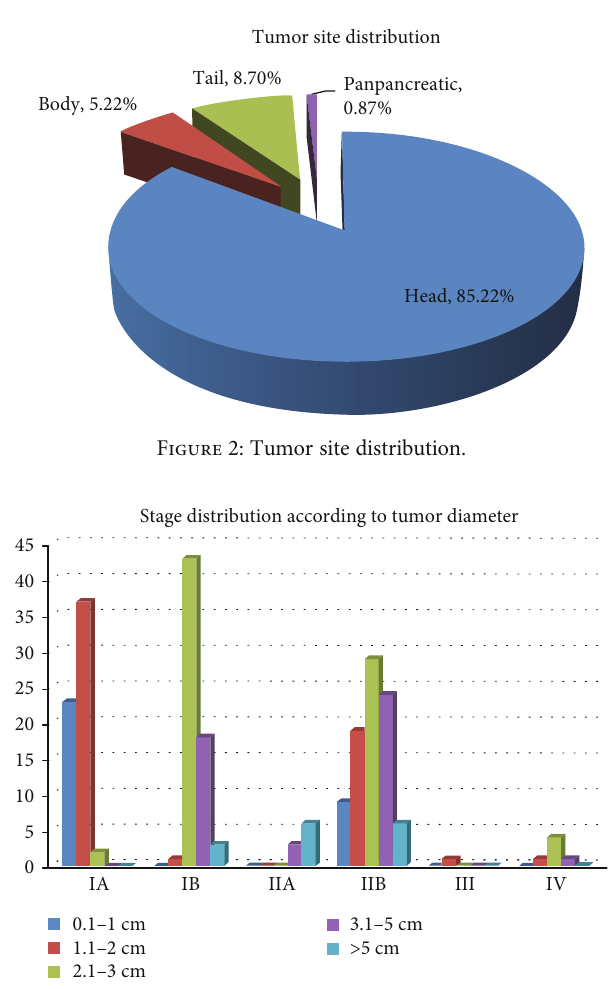
Figure 3: Stage distribution according to tumor diameter.